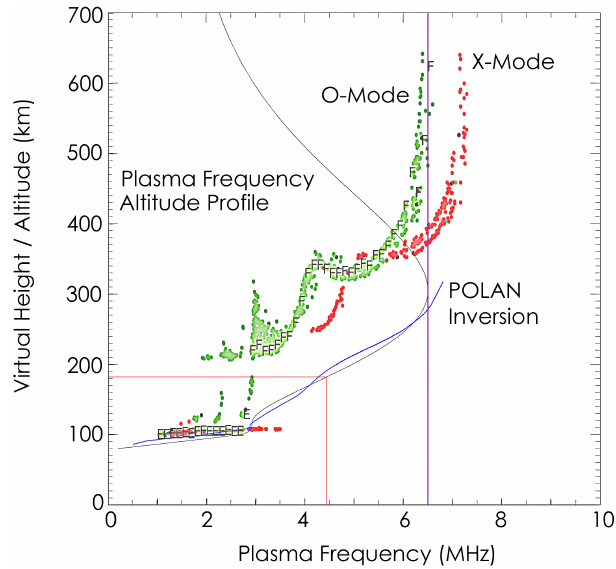
Fig. 6. Plasma frequency as a function of altitude for the ULF wave event at 10:04UT on 16 April 1998. The green dots represent the O-mode ionogram trace and the red dots represent the X-Mode. The curved black line presents the dual Chapman function fitting to the POLAN inversion which is in blue. The red vertical line on the panel shows the DOPE transmission frequency. The reflection altitude for this event was 184km. The vertical purple line shows the approximate frequency corresponding to peak Fo